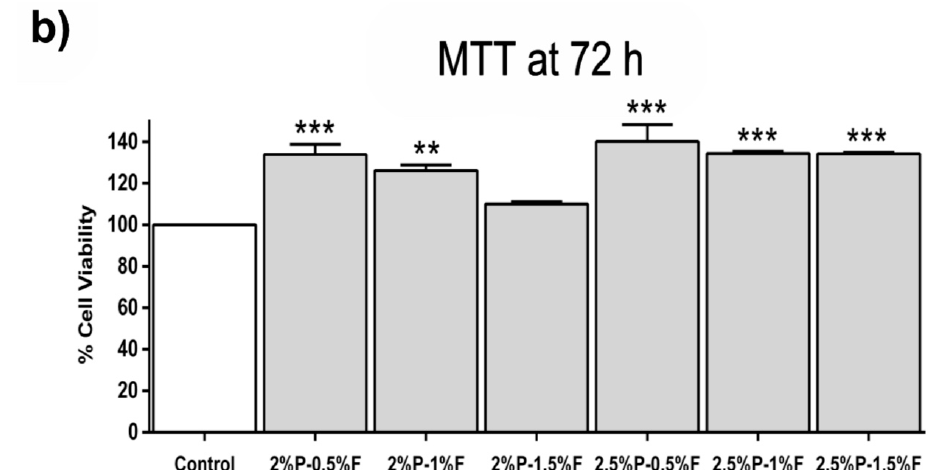
Figure 4. MTT assay at ( a ) 48 h and ( b ) 72 h. Results are expressed as the mean ± standard deviation of triplicates. p -value less than 0.05 (* p < 0.05, ** p < 0.01, and *** p < 0.001) indicates statistically significant difference by one-way ANOVA and Tukey’s test.